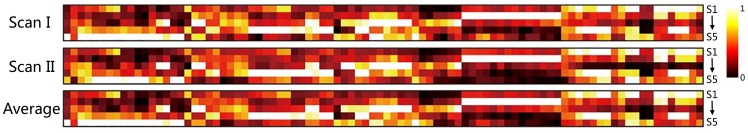
The clustering results for scan I, scan II and the averaged centers from two scans. The hotter regions represent a higher level of node centrality.